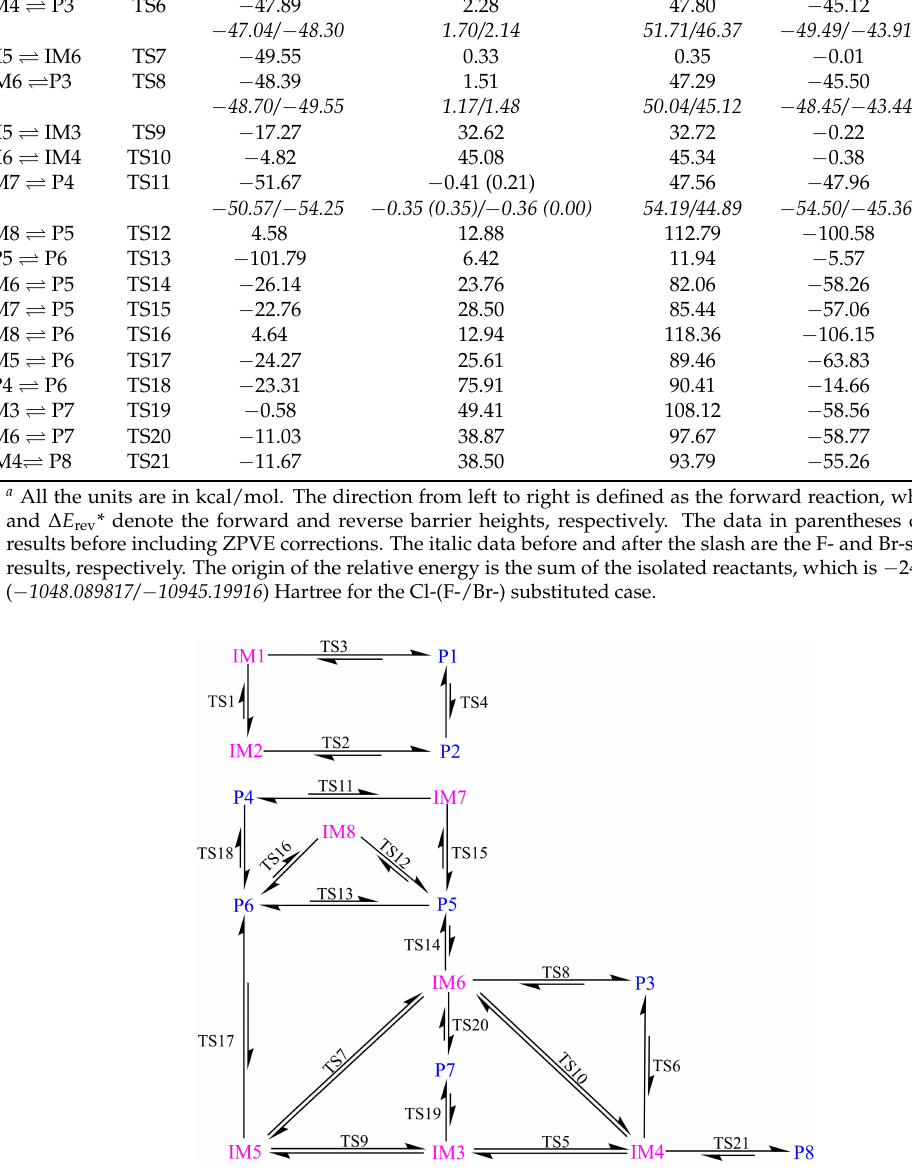
Figure 4. Schematic diagram for the interconversion among initial intermediates and products. The short and two-way arrows denote the high barrier height for the forward reaction and the almost equivalent barrier height for the forward and reverse reaction,